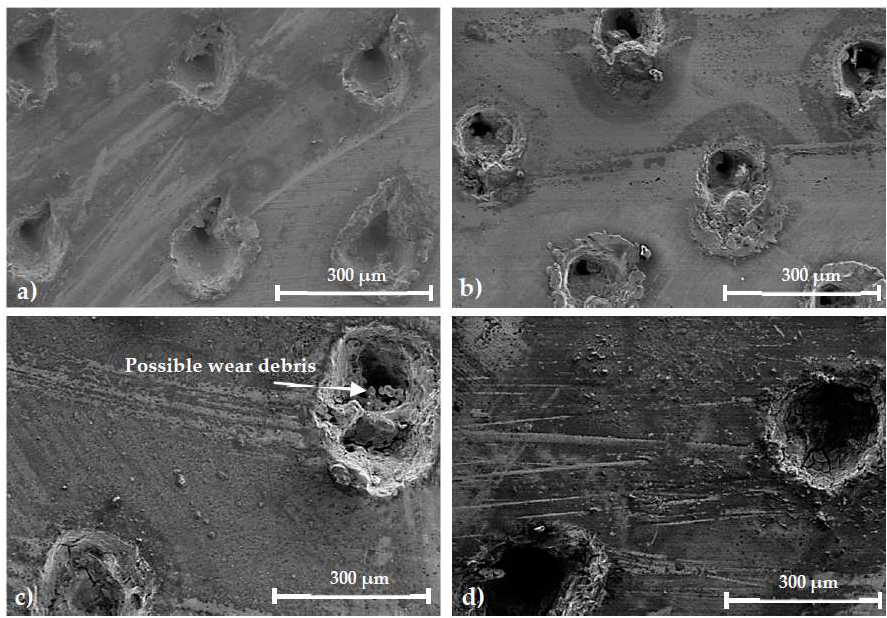
Figure 10. SEM micrographs obtained after the tribological test on the wear track of the samples: ( a ) M2, ( b ) M3, ( c ) M6, and ( d ) M8.